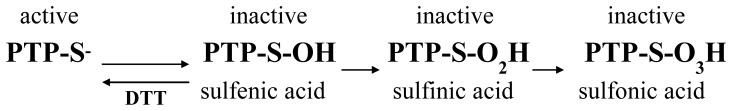
Oxidation steps of PTP catalytic cysteine residue.The cysteine residue exists in a thiolate anion form and may undergo oxidation to the inactive sulfenic acid residue form. This conversion is reversible, but highly oxidizing conditions can further induce oxidation to the sulfinic and sulfonic acid residues, which is considered irreversible under physiological conditions.